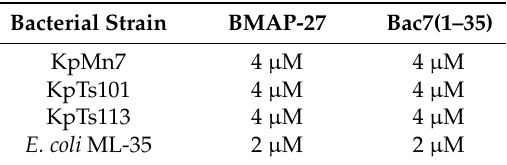
Table 2. Minimum inhibitory concentration (MIC) values of BMAP-27 and Bac7(1–35) against the three Klebsiella strains and the E. coli ML-35 strain used to evaluate the protective effect of the